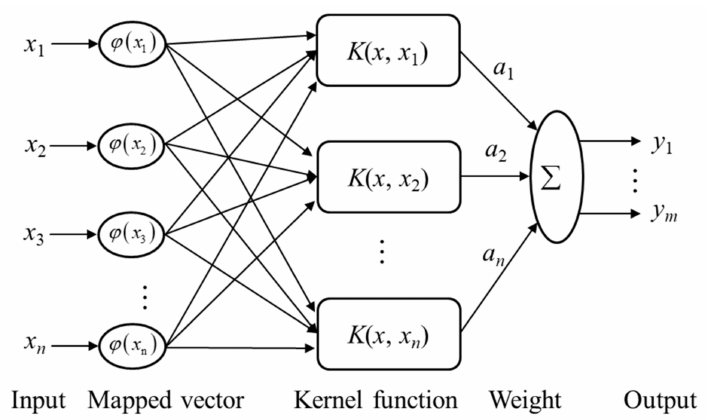
Figure 4. Architecture of the SVM.